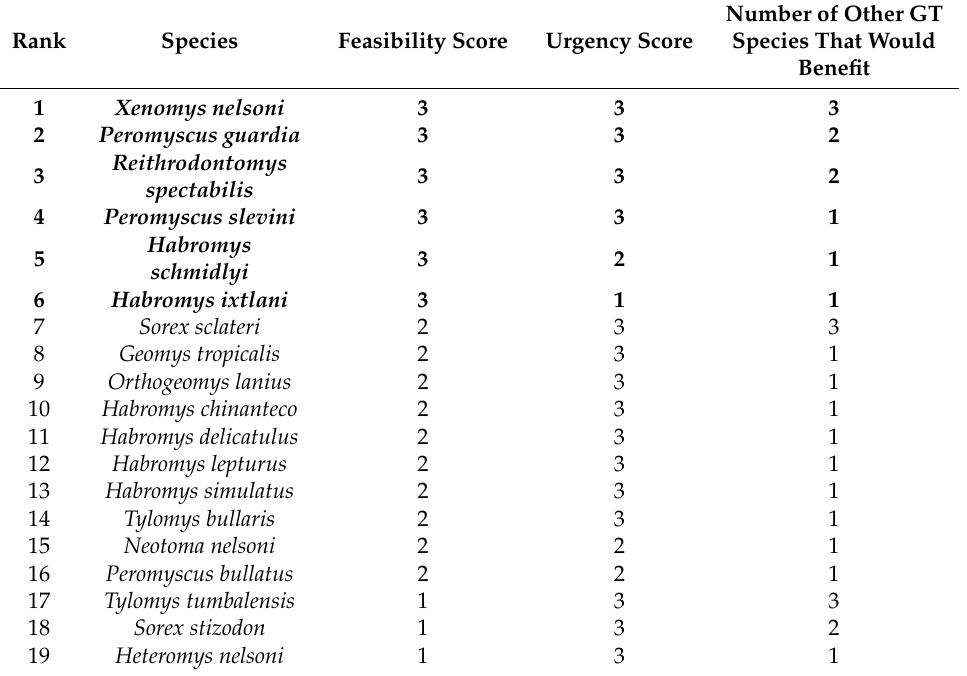
Table 4. Results of the prioritization process for critically endangered Rodentia and Eulipotyphla species for Mexico, with the top 6 species selected, in bold text. Rank Species Feasibility Score Urgency Score